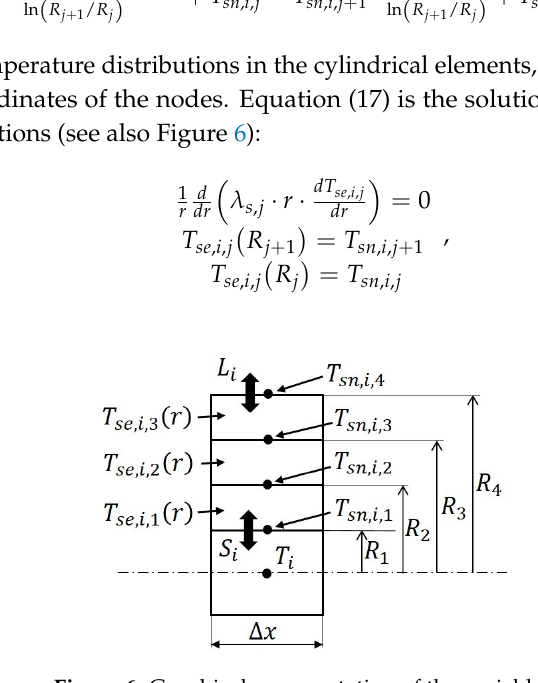
Figure 6. Graphical representation of the variables.